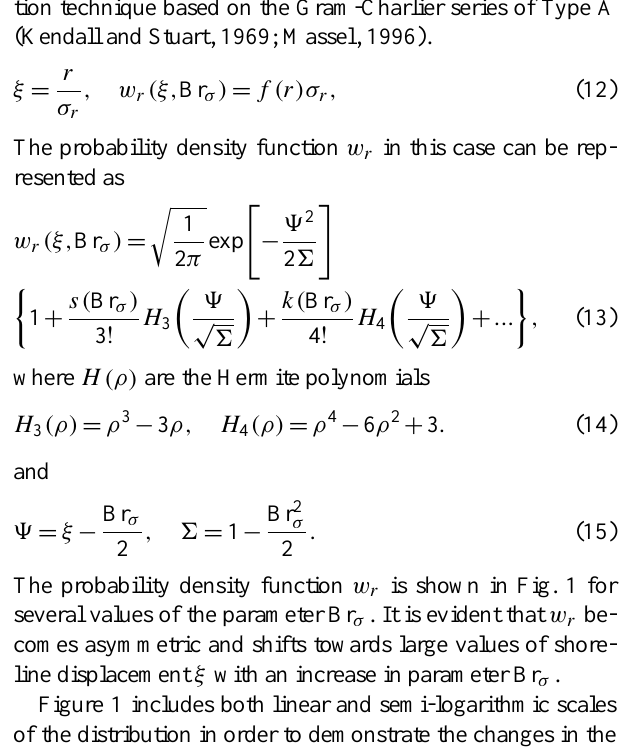
Experimental investigations were completed in the new wave flume at the University of Warwick, of dimensions, 22 m long, 0.6 m wide and an operating water depth of 0.5 m. The channel is equipped with an absorbing-piston type wavemaker (Spinneken & Swan, 2009). The wavemaker